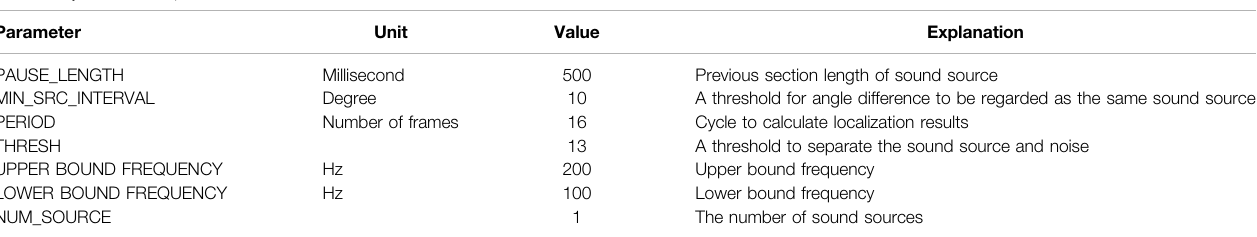
TABLE 1 | Localization parameters of